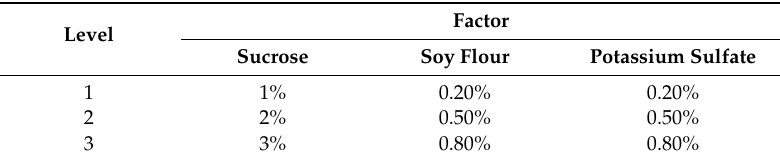
Table 2. Factors and their respective assigned levels.